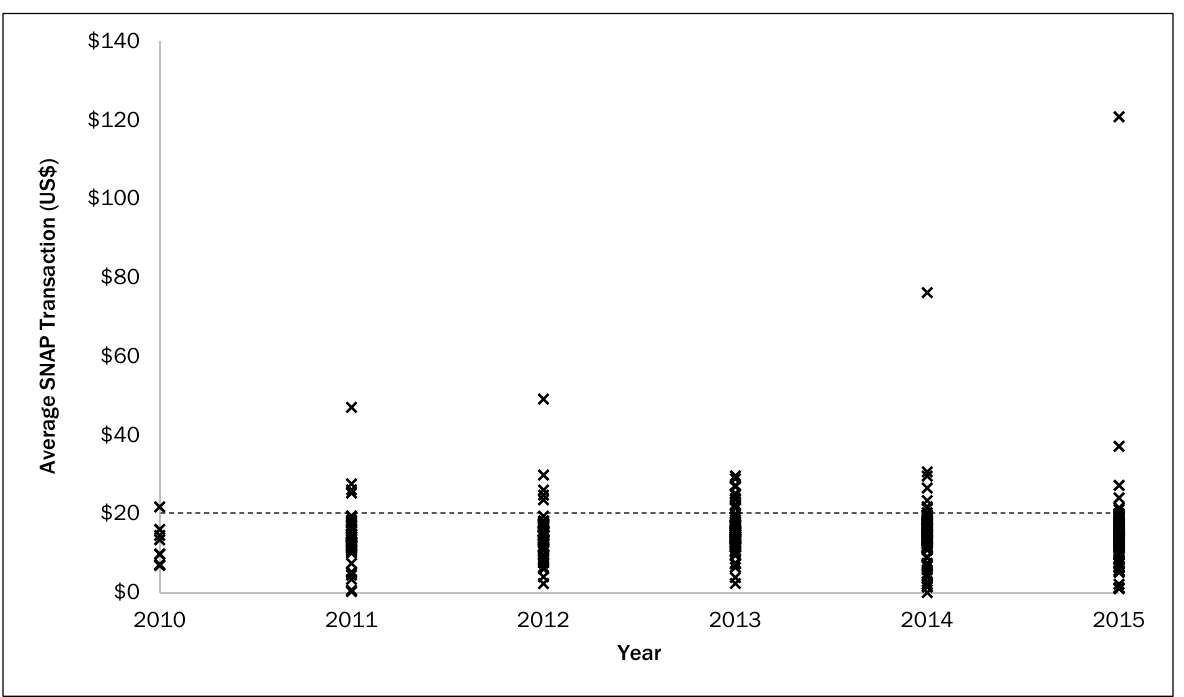
Figure 1. Plot of Average SNAP Transactions in Farmers Markets Participating in the Double Up Food Bucks Program